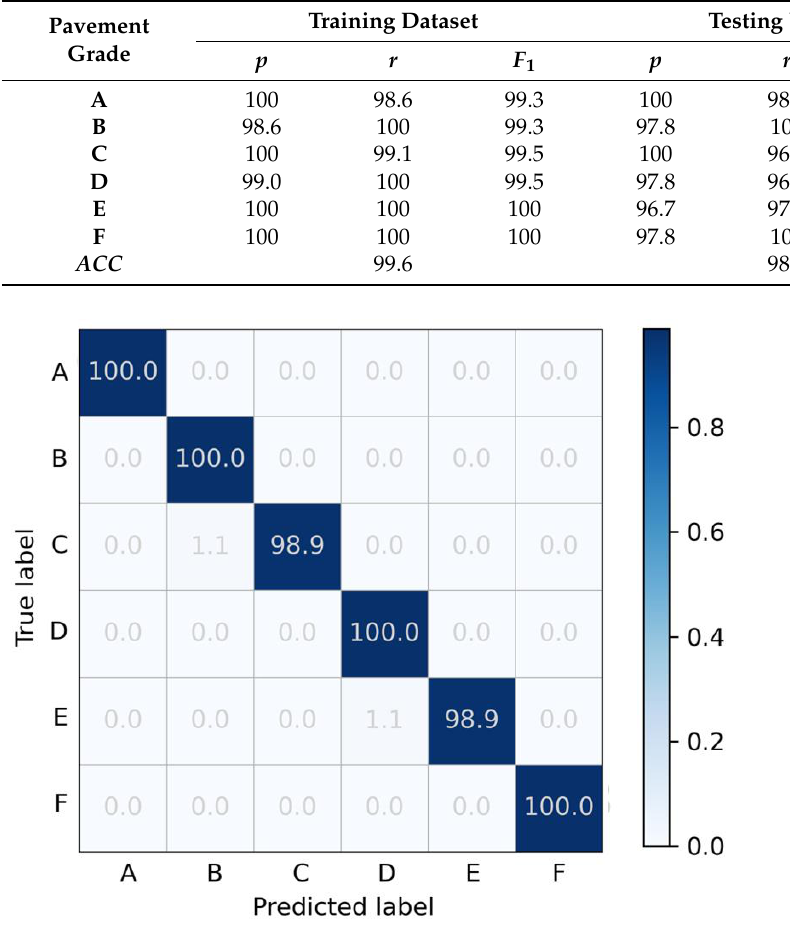
Figure 8. Confusion matrix of the 1D-RCNN for roughness grade classification (unit: %).